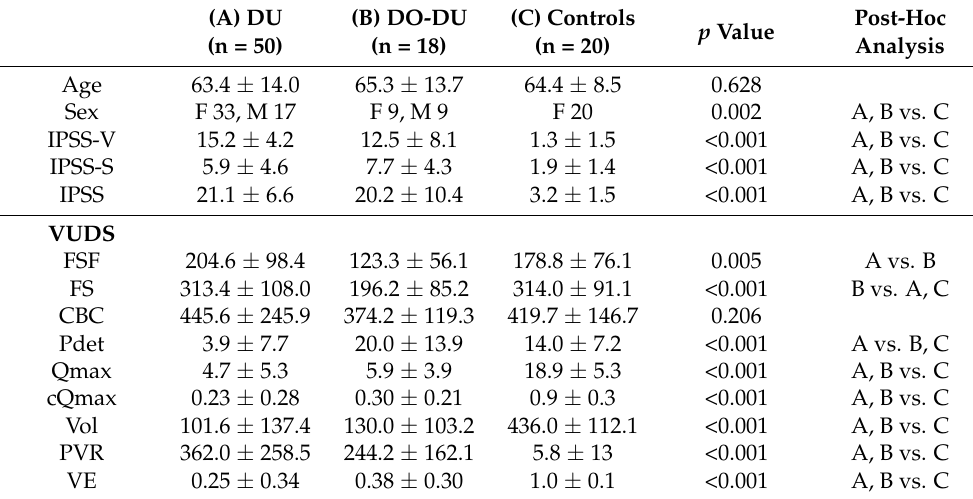
Table 1. Clinical characteristics of DU, DO-DU patients, and